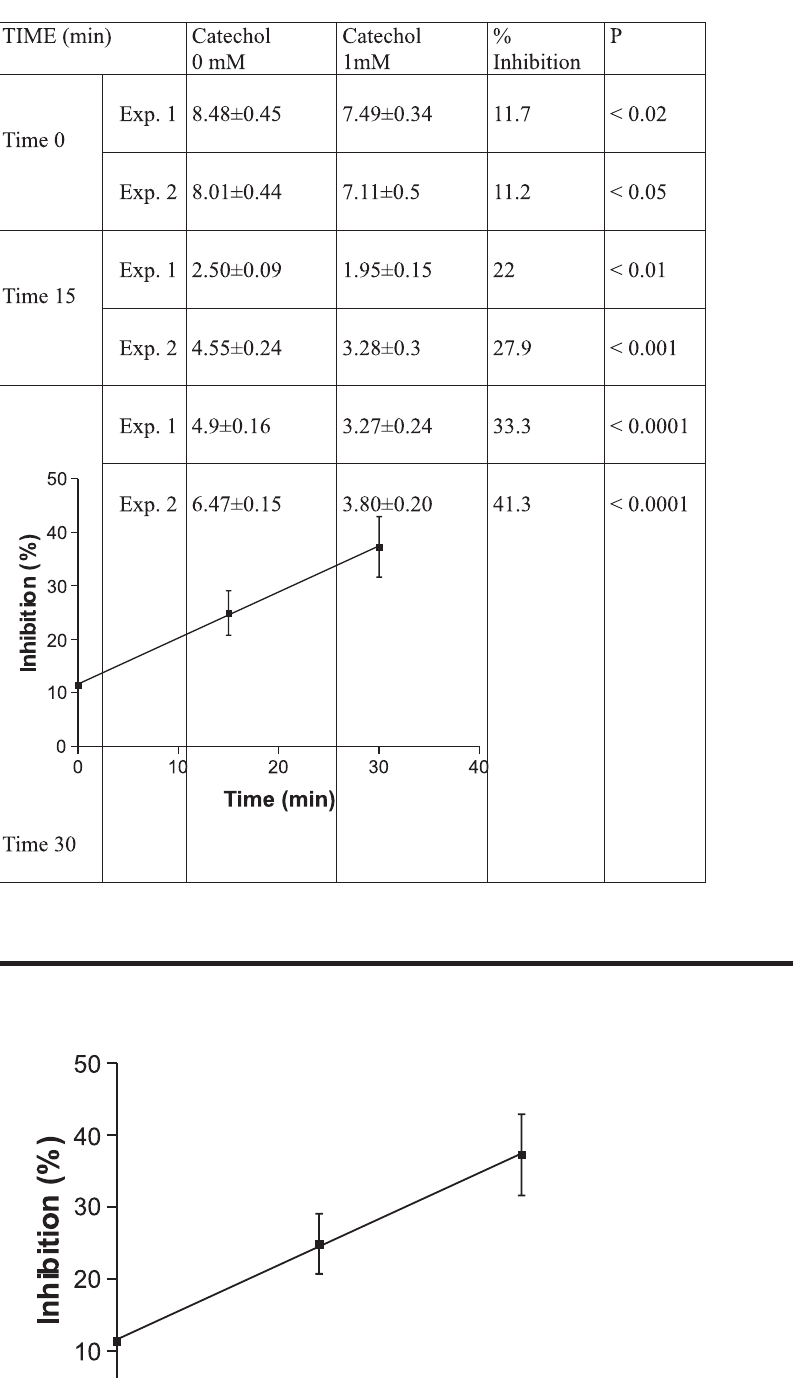
-linked respiration and the time of incubation of 2